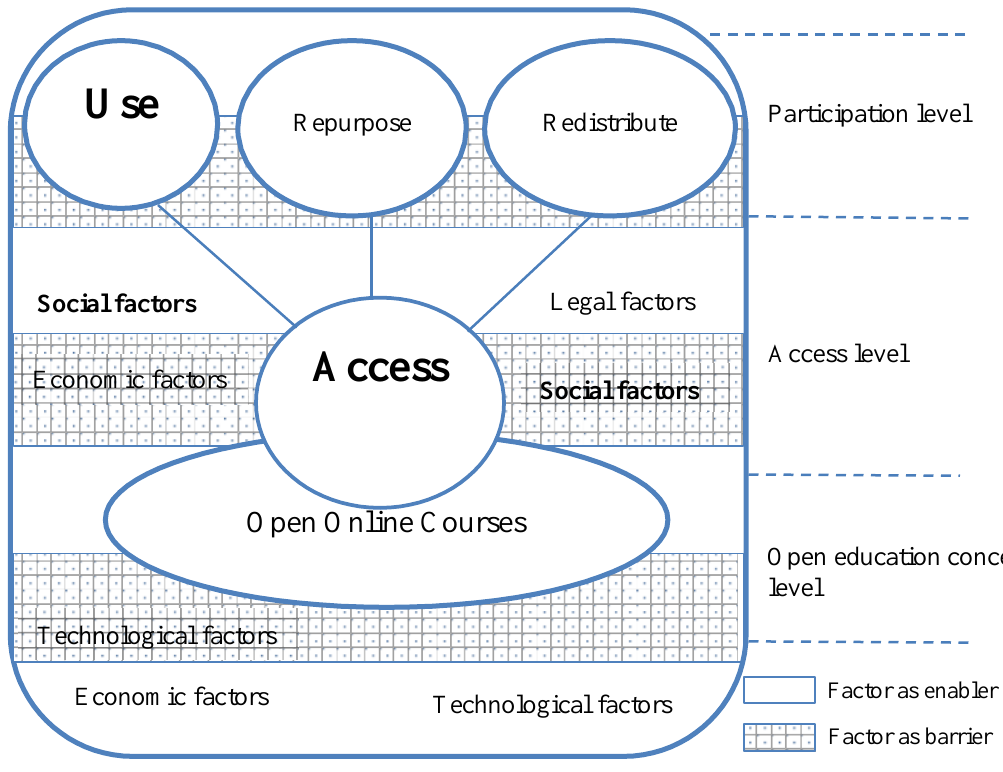
Figure 1. A framework for access to open online courses from the perspective of the learner of a developing